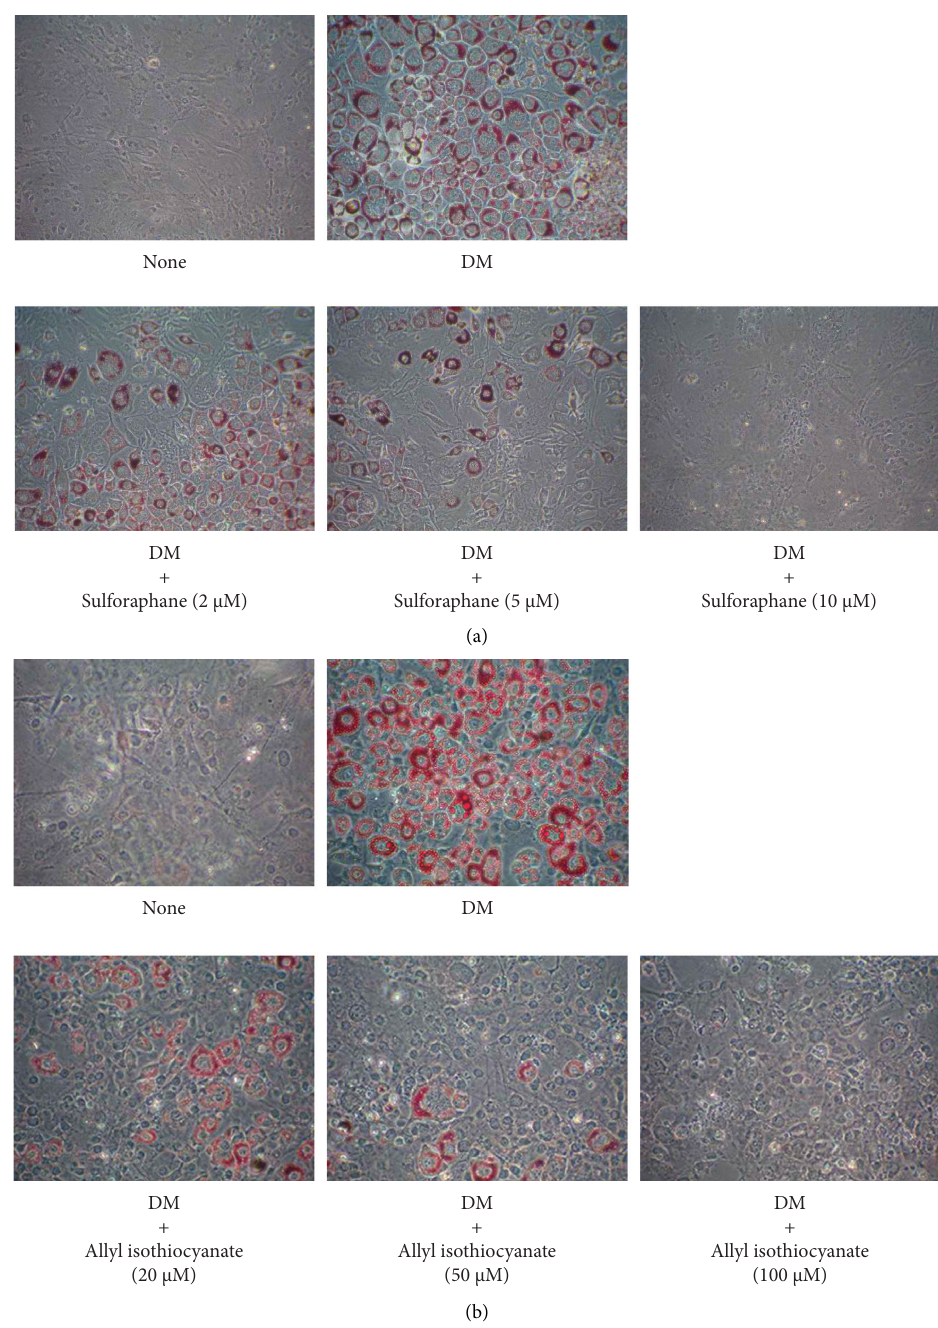
Figure 3: Results of Oil Red O staining of 3T3-L1 adipocytes treated with sulforaphane (a) or allyl isothiocyanate (b), representative images from six independent